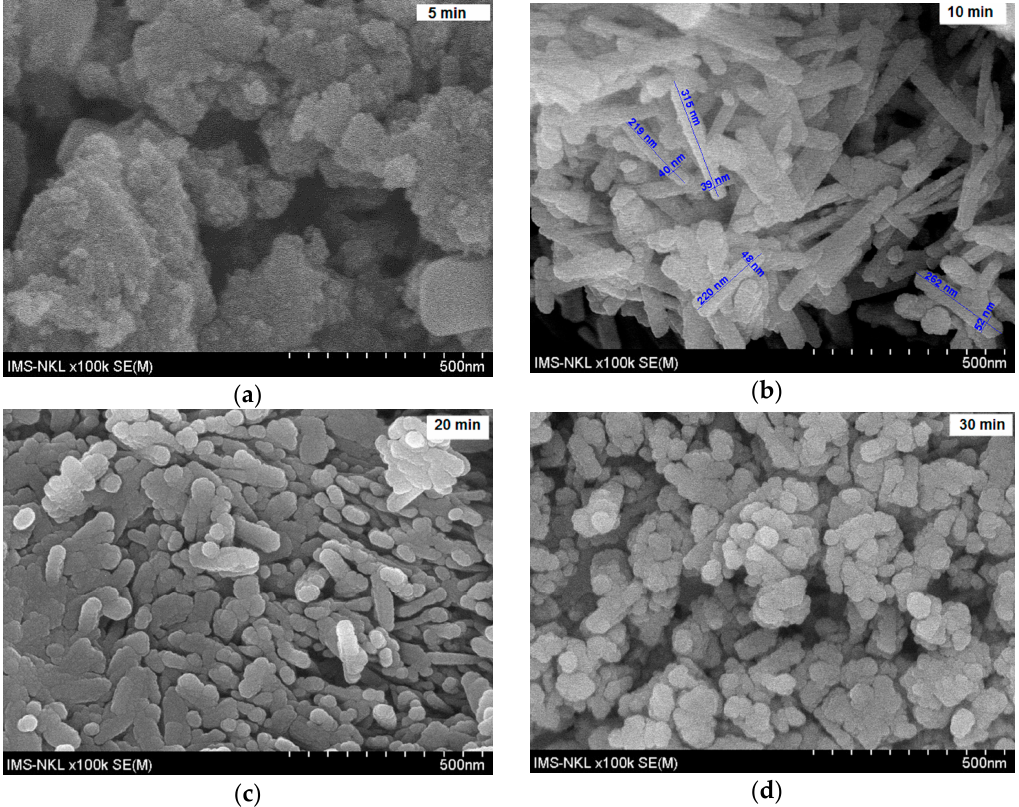
Figure 2. SEM images of the powders obtained in 5 min ( a ); 10 min ( b ); 20 min ( c ); and 30 min ( d ).